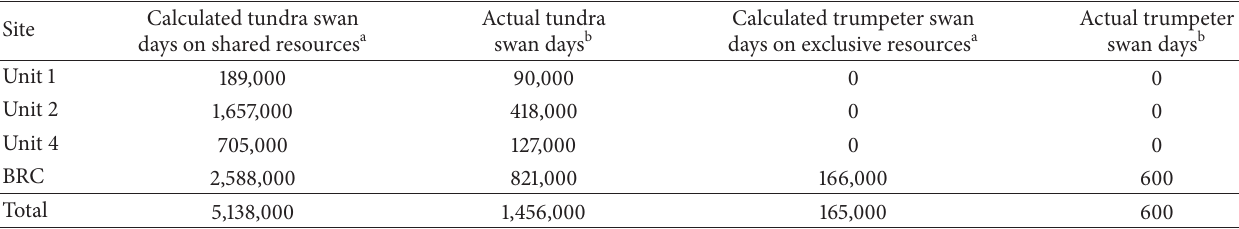
Table 2: Comparison of tundra and trumpeter swan days that the tuber resource (Table 1) could potentially support and the number of tundra and trumpeter swans actually observed foraging in the four study wetlands. We assume tundra swans require 258.5 g tubers/day (twice basal metabolic rate) and trumpeter swans require 361.8 g tubers/day. Swans are likely to ingest more tuber biomass per day during staging to maximize energy